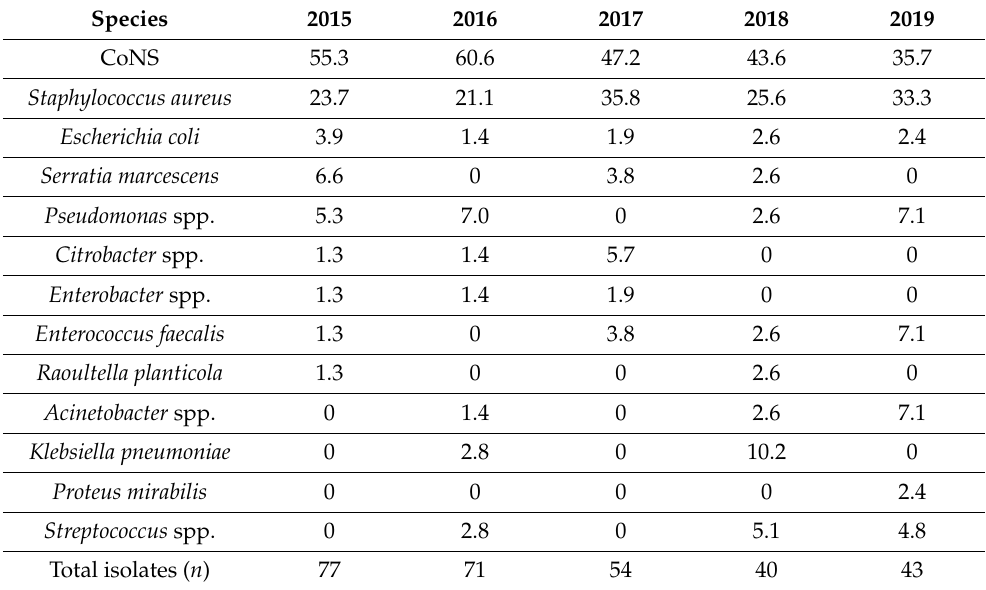
Table 3. Bacteria isolated (%) from conjunctival samples of patients with ocular disease by year.